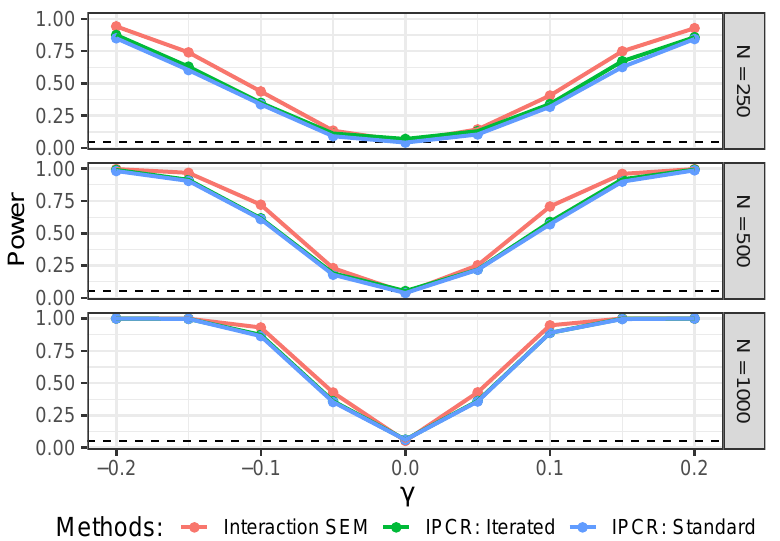
Figure 11. The power of standard and iterated IPC regression and SEMs with a product term to detect the dependency of the regression parameter β on the covariate z . The dashed line marks a power of